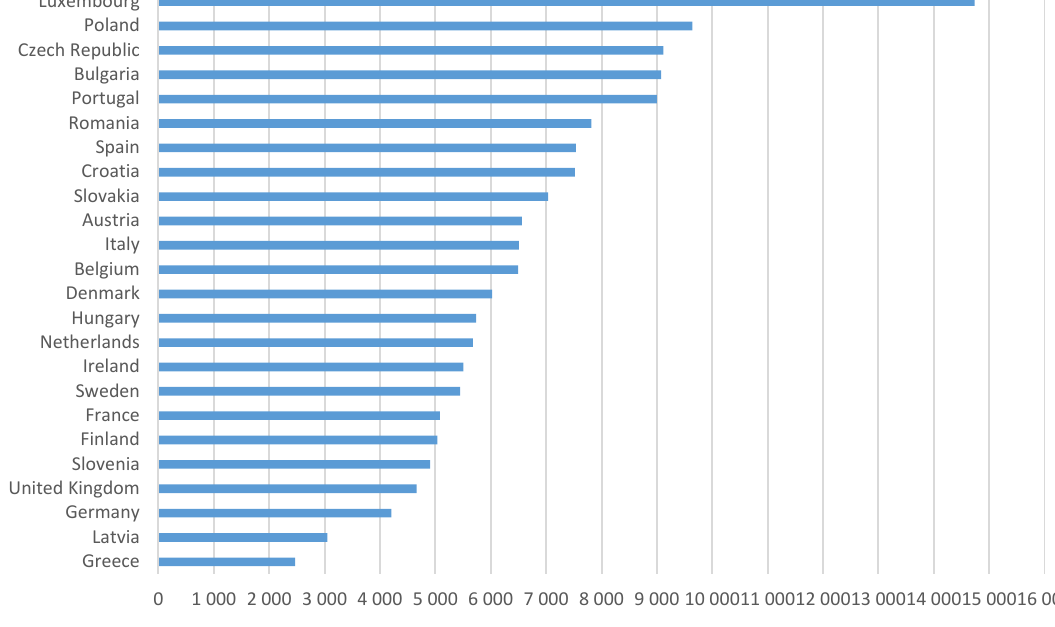
Figure 1. Average electronic file size by country